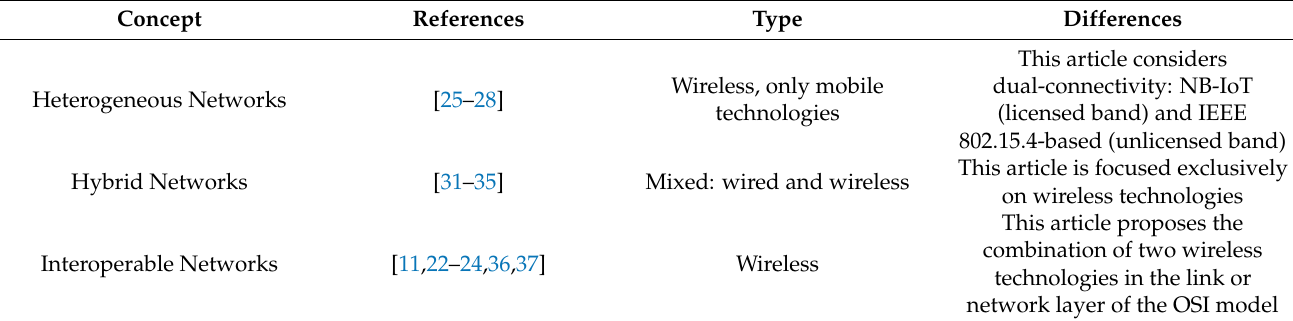
Table 2. Comparison between this work and other terminology in the